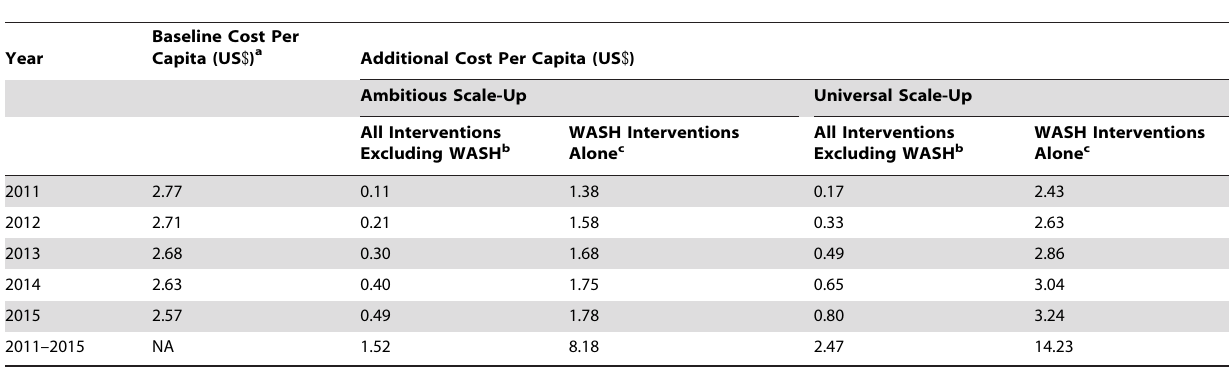
Table 3. Additional cost per capita to achieve targeted coverage rates for the ambitious and universal scale-up scenarios by 2015. Baseline Cost Per Year Capita (US $ ) a Additional Cost Per Capita (US $ ) Ambitious Scale-Up Universal Scale-Up WASH Interventions All Interventions WASH Interventions All Interventions Alone c Excluding WASH b Alone c Excluding WASH b